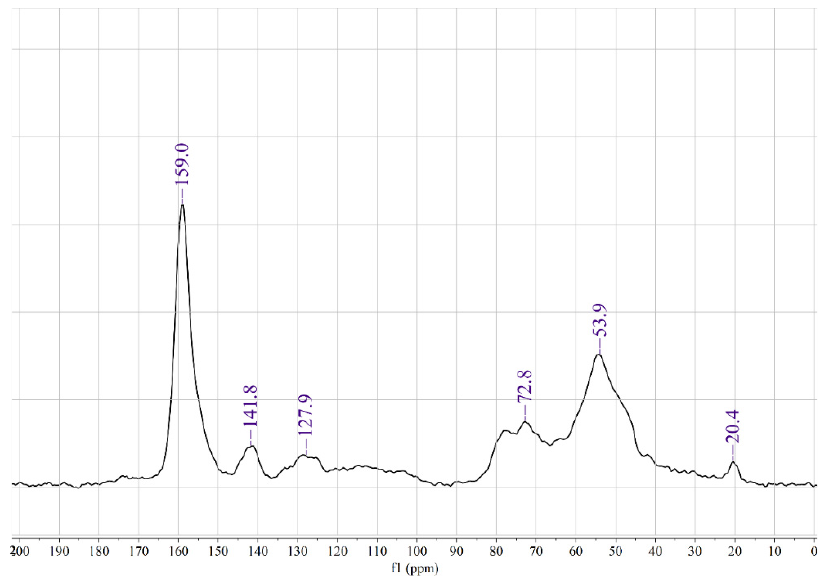
Figure 3. Solid-state 13 C NMR spectrum of TUF6 resin. Table 6. Assignments of the relevant peaks in 13 C NMR spectra of UF and TUF resins. Chemical Shift (ppm)